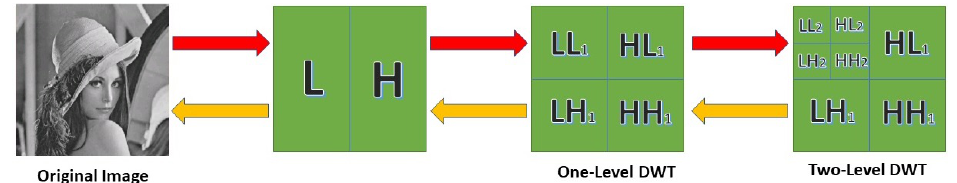
Figure 3. The process of two-level decomposition using the discrete wavelet